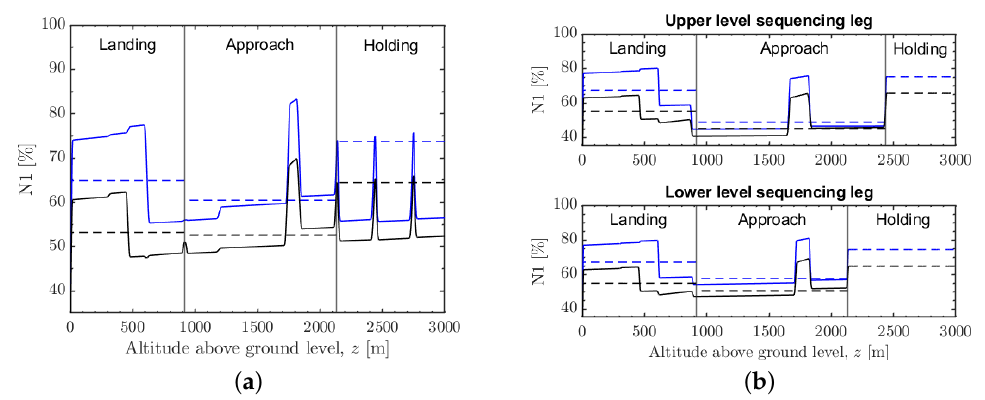
Figure 11. N1 profiles (solid lines) and corresponding mean N1 values per flight phase (dashed lines) for the ( a ) vertical holding stack and ( b ) linear hold point merge: Airbus A320 (black lines) and Boeing B77W (blue lines). Table 5. Investigation on the influence of the N1 values: mean N1 values per aircraft type, holding procedure, and flight